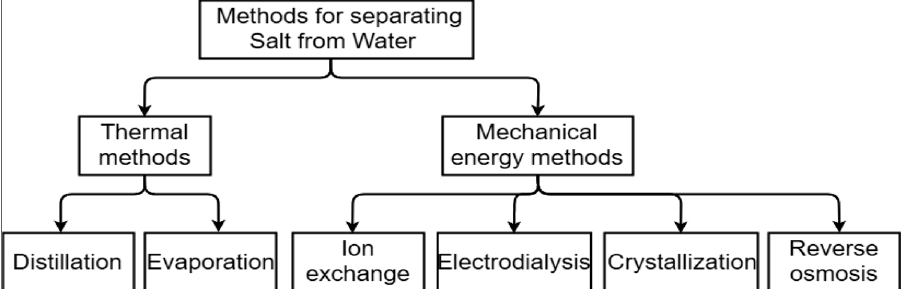
The required values of the dehumidification rate, price, corrosion and health hazard parameters are expressed in bold